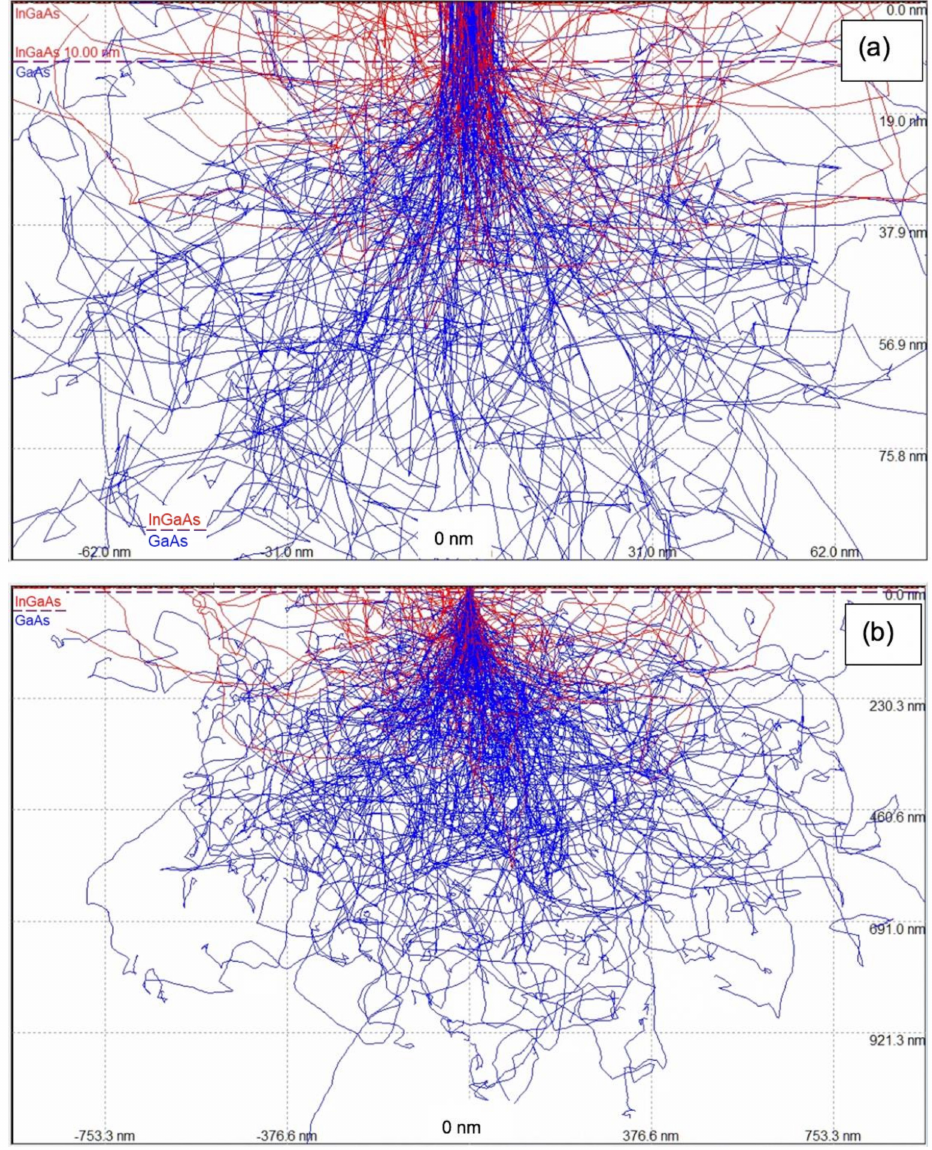
Figure 1. Monte Carlo simulation of multiple electron scattering for a 10 nm wide beam through 10 nm In 0.1 Ga 0.9 As film on GaAs substrate at energies of 4 keV ( a ) and 15 keV ( b ). Trajectories of back-scattered electrons are shown in red, those of absorbed electrons in blue. Note the different scales: ( a ): 155 nm × 94 nm, ( b ): 1883 nm × 1152